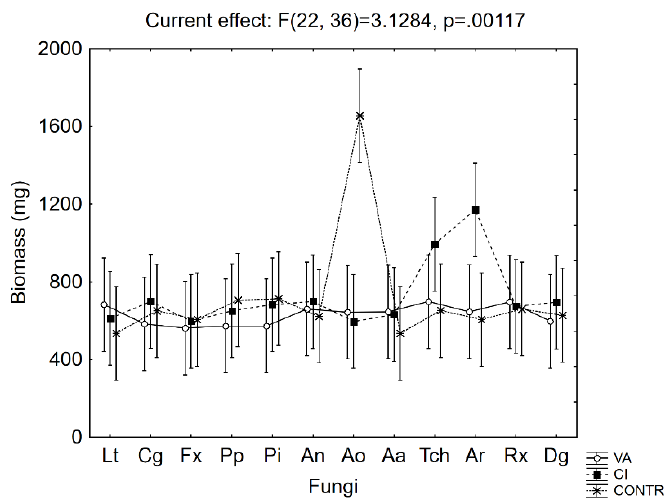
Figure 3. Effective hypothesis decomposition of MANOVA on biomass (mg). Interaction fungi vs. acids (for abbreviations, see Table 1). Vertical bars indicate 95% confidence intervals. The F-test and relative degrees of freedom are given at the top. Contr., liquid medium without acids.